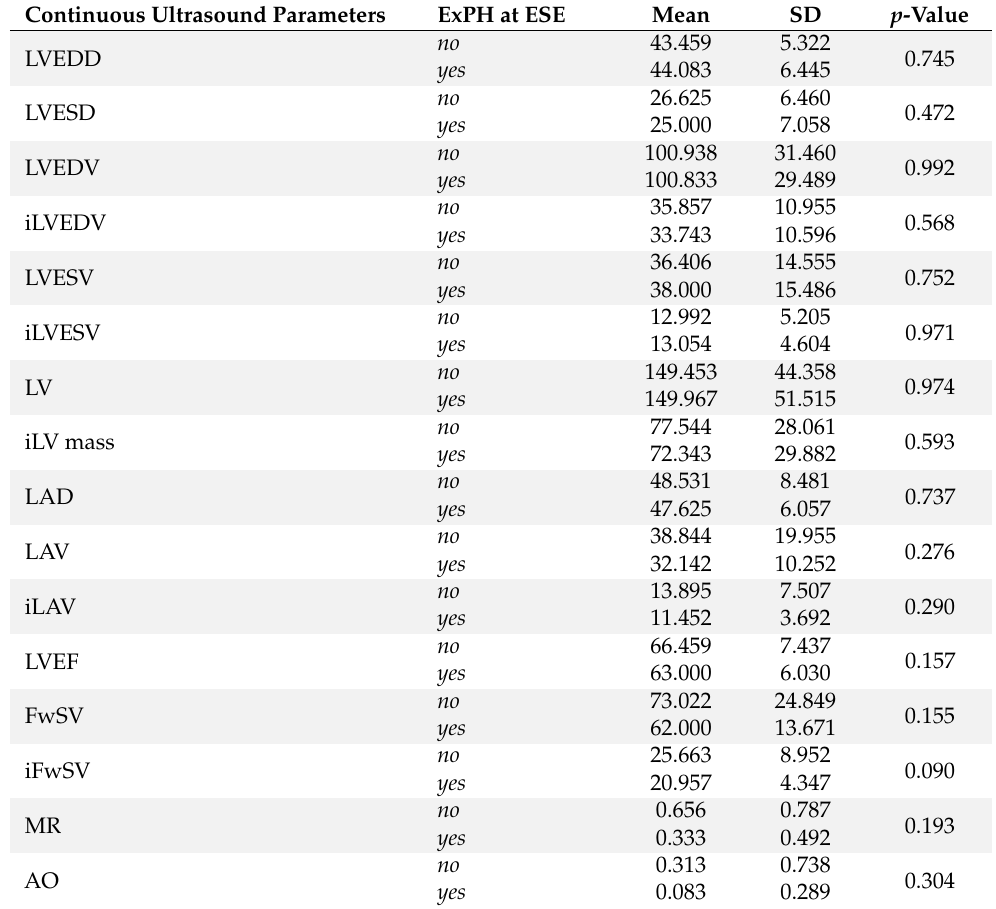
Table A4. ExPH at ESE vs. continuous or categorical ultrasound